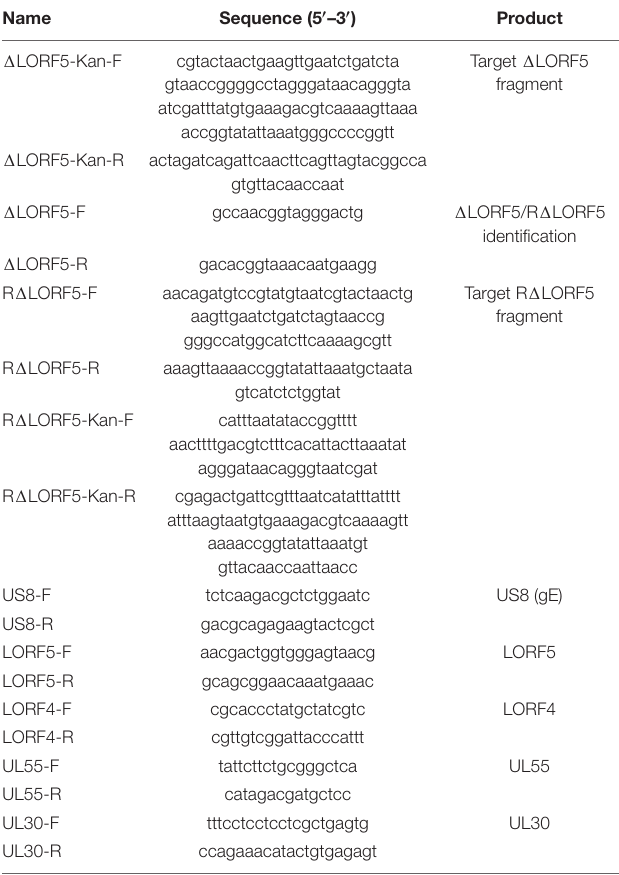
TABLE 3 | Primers used in this